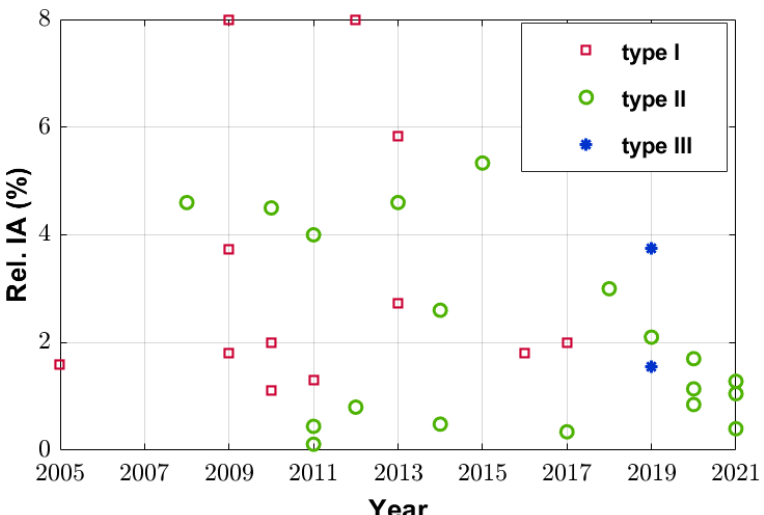
Figure 14. The relative inaccuracy (Rel. IA) versus the year of publication, for all three types of MOS-based temperature sensors. The figure also shows the best linear fits (trend types I, II) for the first two types. The relative inaccuracy (Rel. IA) was defined as 100 · PP_IA/specified temperature range where PP_IA is the worst-case inaccuracy (IA) over a specified temperature range.